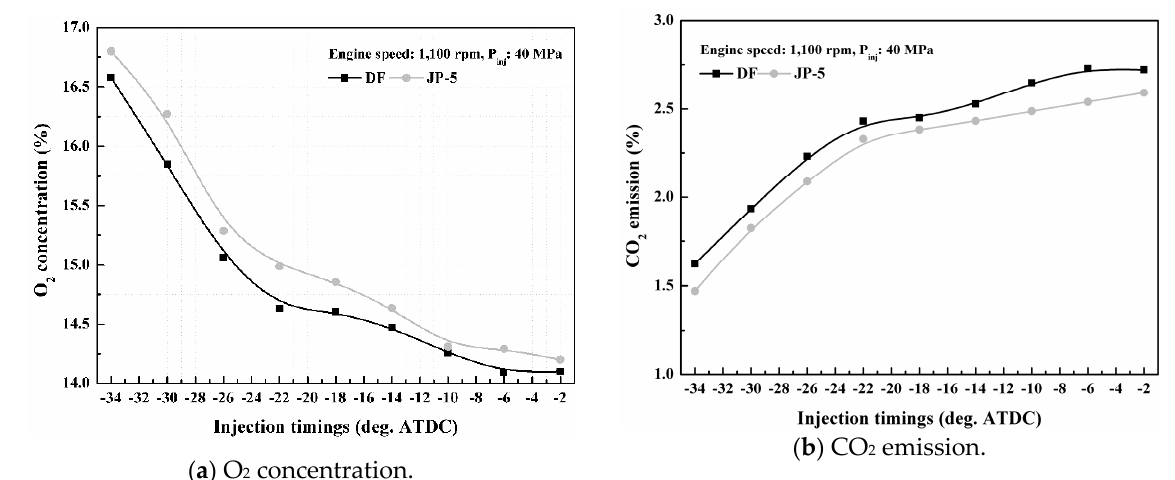
Figure 7. O 2 concentration and CO 2 emission characteristics with injection timings.